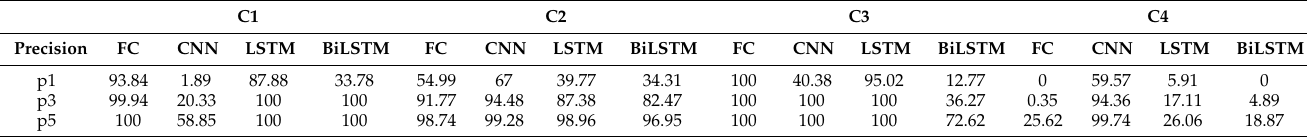
Table 16. Precision @k for most anomalous